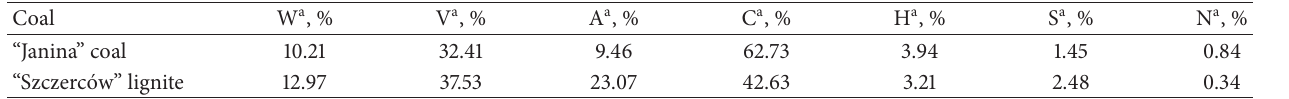
Table 1: Characteristics of coals used.